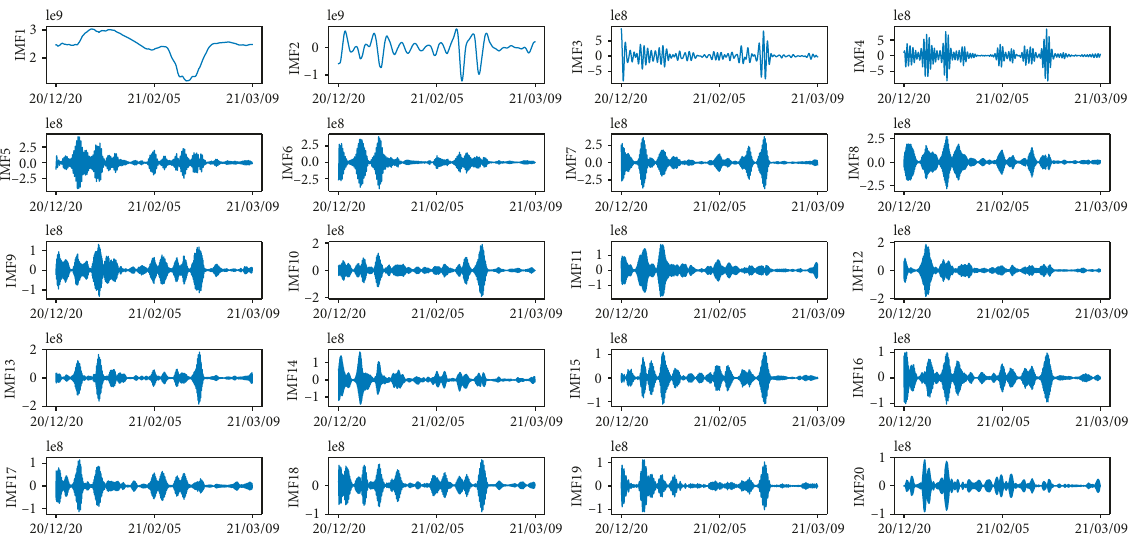
Figure 7: The 20 subseries of outflow flow decomposed by